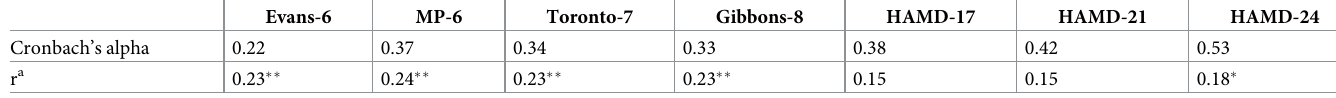
Table 3. Reliability and concurrent validity measures of the HAMD subscales and full versions at baseline.